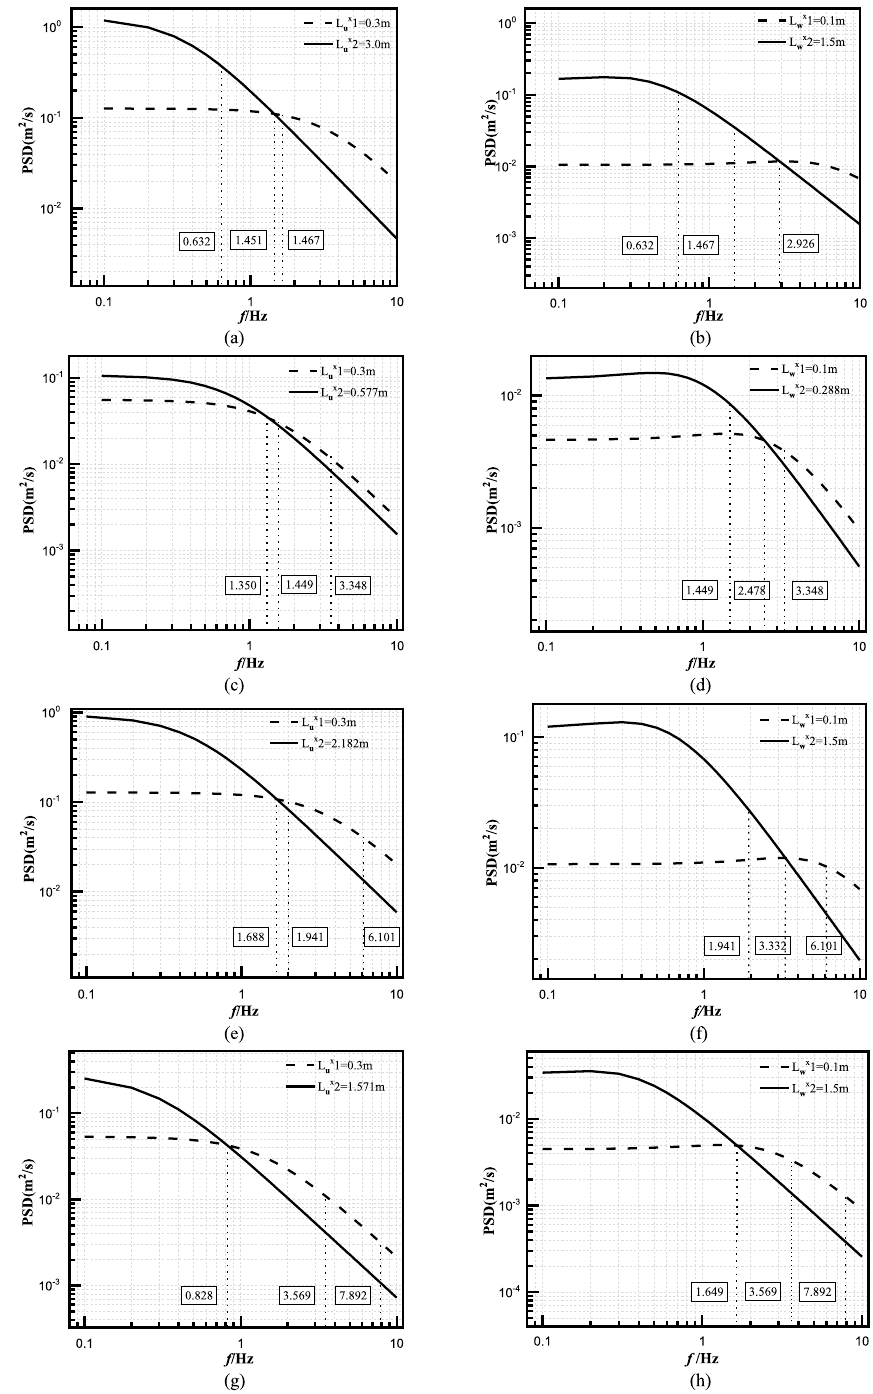
Fig. 15 Buffeting calculation results under different models and wind spectrum input conditions (Von Karman spectra). a Horizontal wind spectra for bridge A (1:40). b Vertical wind spectra for bridge A (1:40). c Horizontal wind spectra for bridge A (1:208). d Vertical wind spectra for bridge A (1:208). e Horizontal wind spectra for bridge B . f Vertical wind spectra for bridge B . g Horizontal wind spectra for bridge C . h